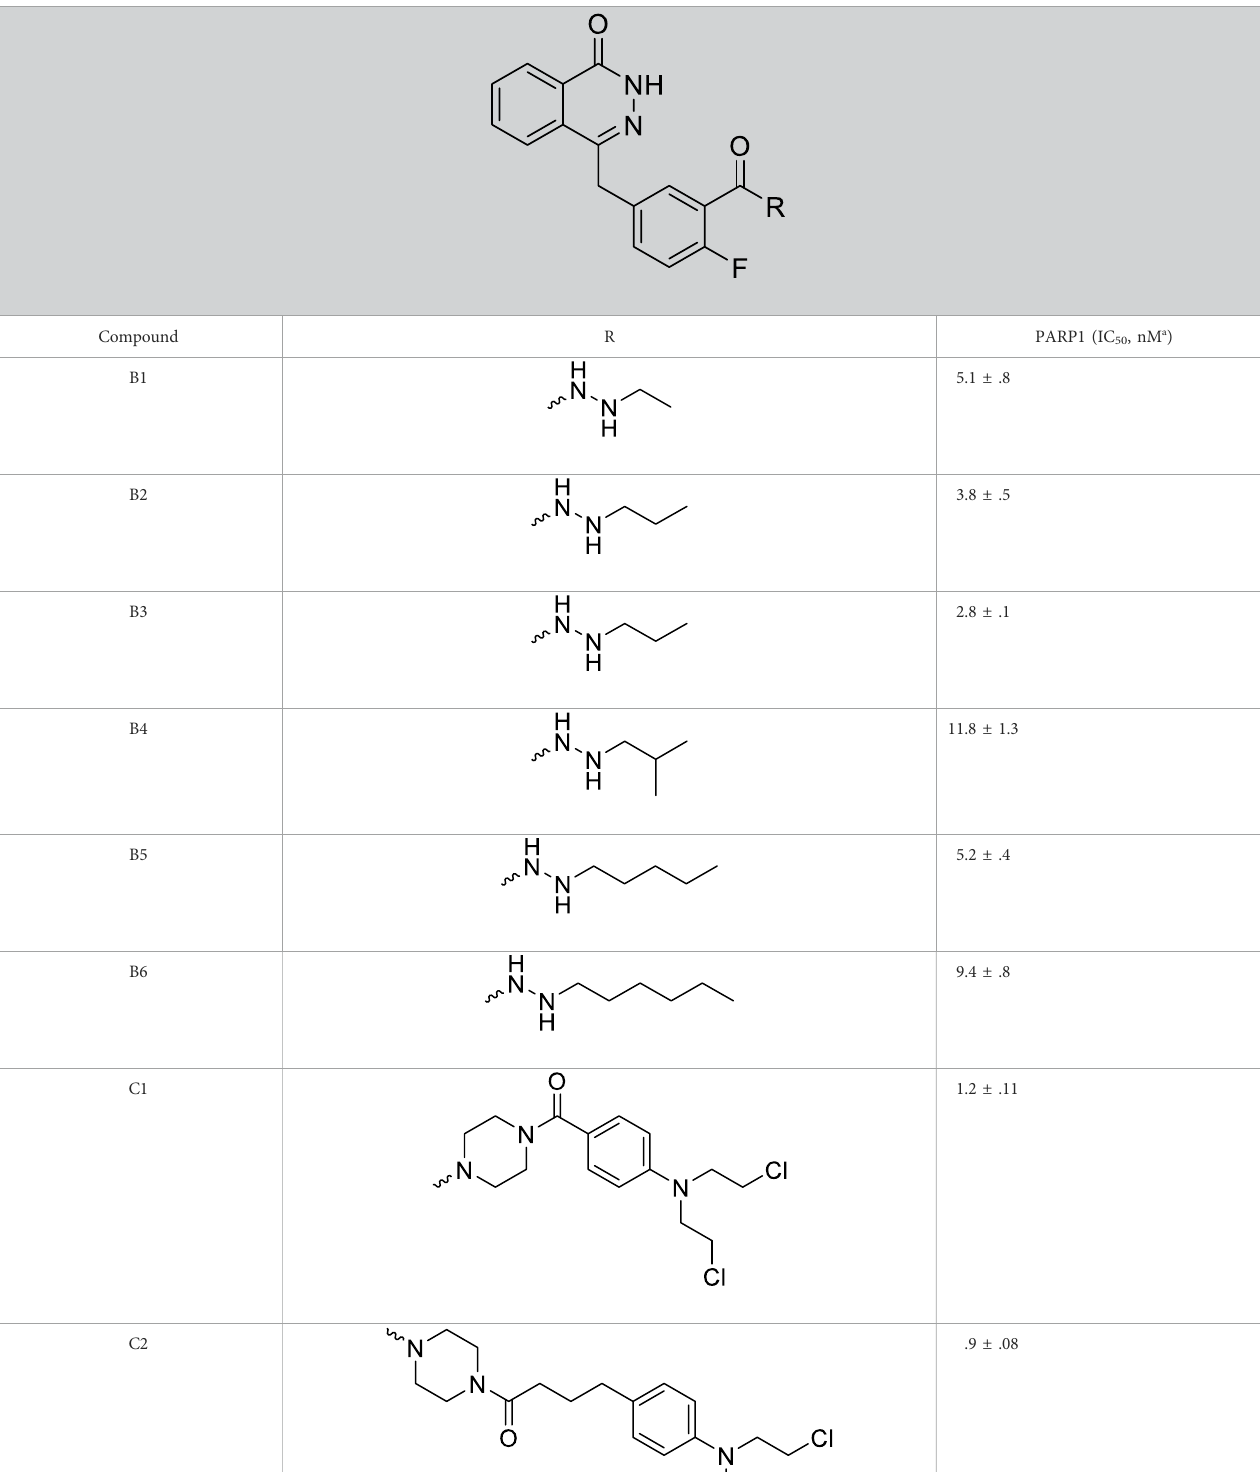
TABLE 2 Structure and PARP1 inhibitory activities of B and C series PARP